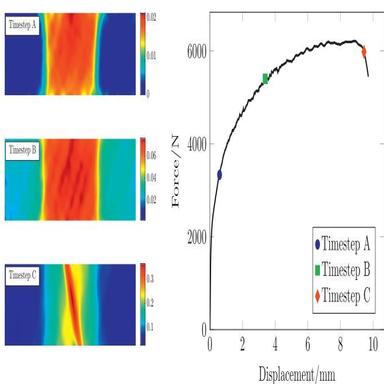
Uniaxial tensile test experiments on THTB specimens: a) full-field logarithmic xx strain component for three timesteps; b) measured total force–displacement curve.